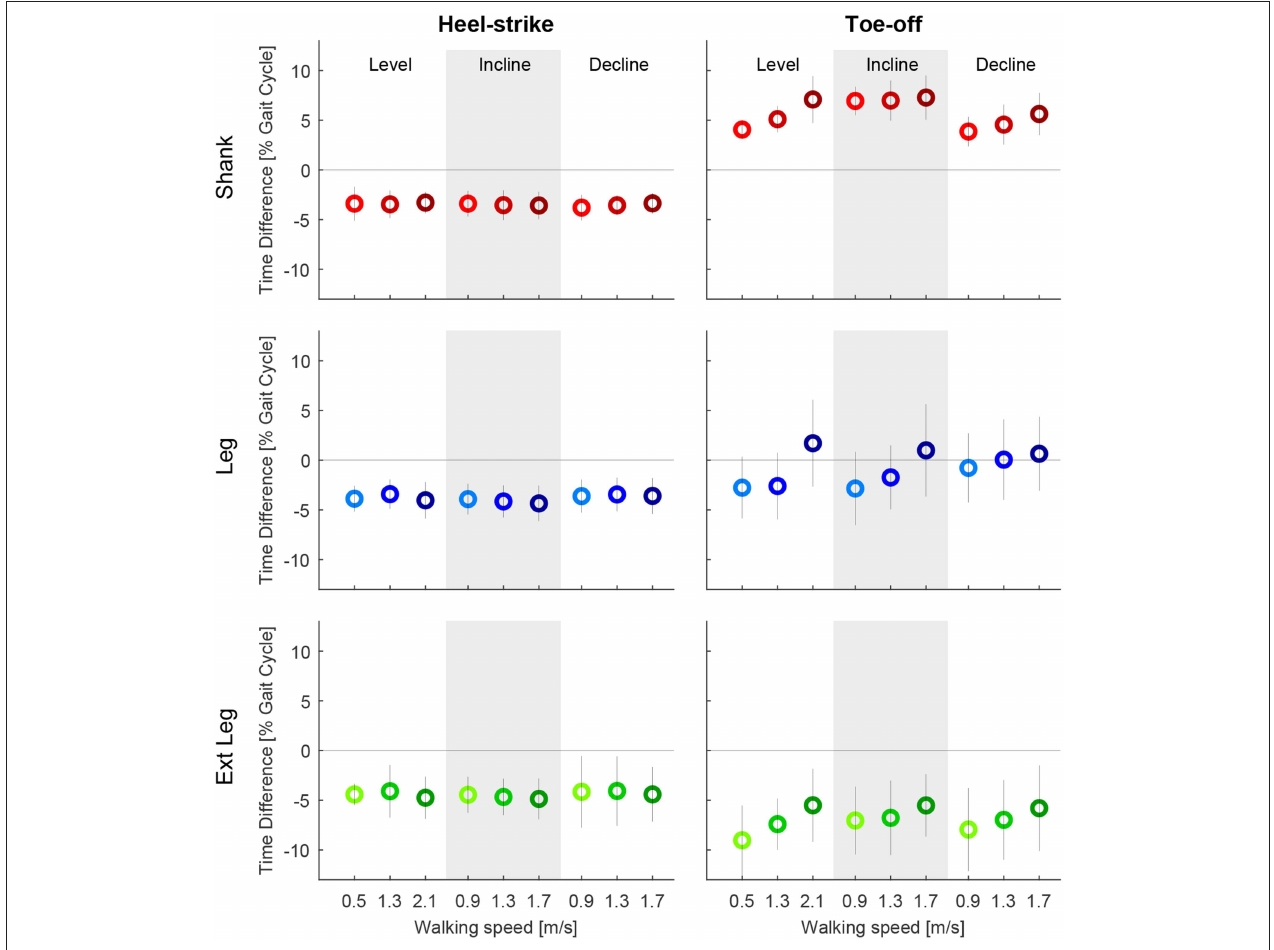
FIGURE 9 | Time difference of the mean zero crossings of the angular velocity based on the inertial measurement unit to the heel-strike (left) and the toe-off (right) identified by ground reaction forces (GRF). Evaluated segment angular velocities from the thigh (orange), shank (red), leg (blue), and extended leg (green). Distances are evaluated for three different speeds of level walking, walking inclines, and walking declines. Darker colors indicate greater speeds (0.9, 1.3, and 1.7m/s for slopes, and 0.5, 1.3, and 2.1m/s for level walking). The standard deviation is indicated by the vertical line. As multiple zero crossings occur for all segments, specific detection rule sets were designed to only detect one transition for each event. Positive and negative values indicate zero crossings after and before, respectively, the GRF based event